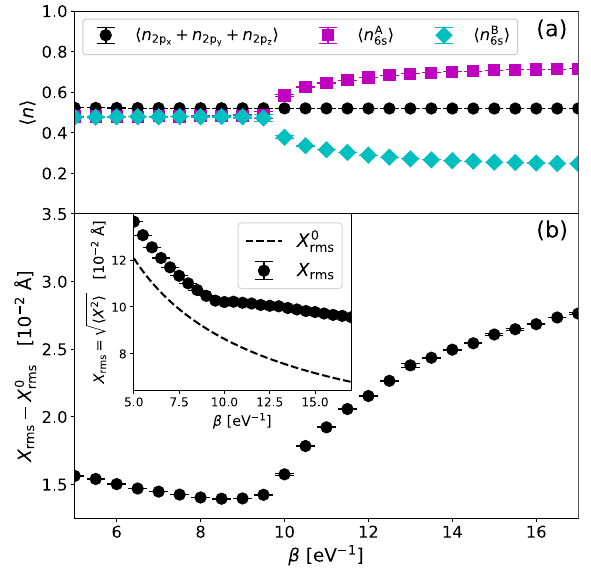
Fig. 3 Local quantities versus β for the L = 10 system. a The total density of holes on the O 2 p σ orbitals (black circles) remains approximately independent of β as the temperature is lowered below T cdw . The hole densities on the Bi 6 s orbital A and B i and h n B i , respectively, bifurcate near T sublattices, h n A cdw , 6s 6s indicating the onset of charge order. b The inset shows the root mean square fl uctuations in the phonon position as measured in the presence (black circles) and the absence of interactions, α sp = 0 (dashed line). The main fi gure displays the difference between these two quantities, with an in fl ection point occurring near T cdw . The error bars in this fi gure are the standard deviation of the mean of our